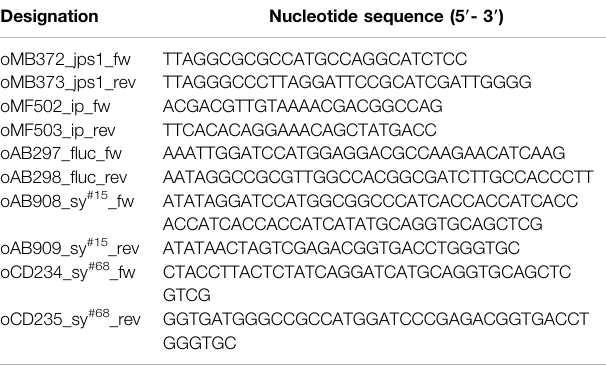
TABLE 1 | DNA oligonucleotides used in this